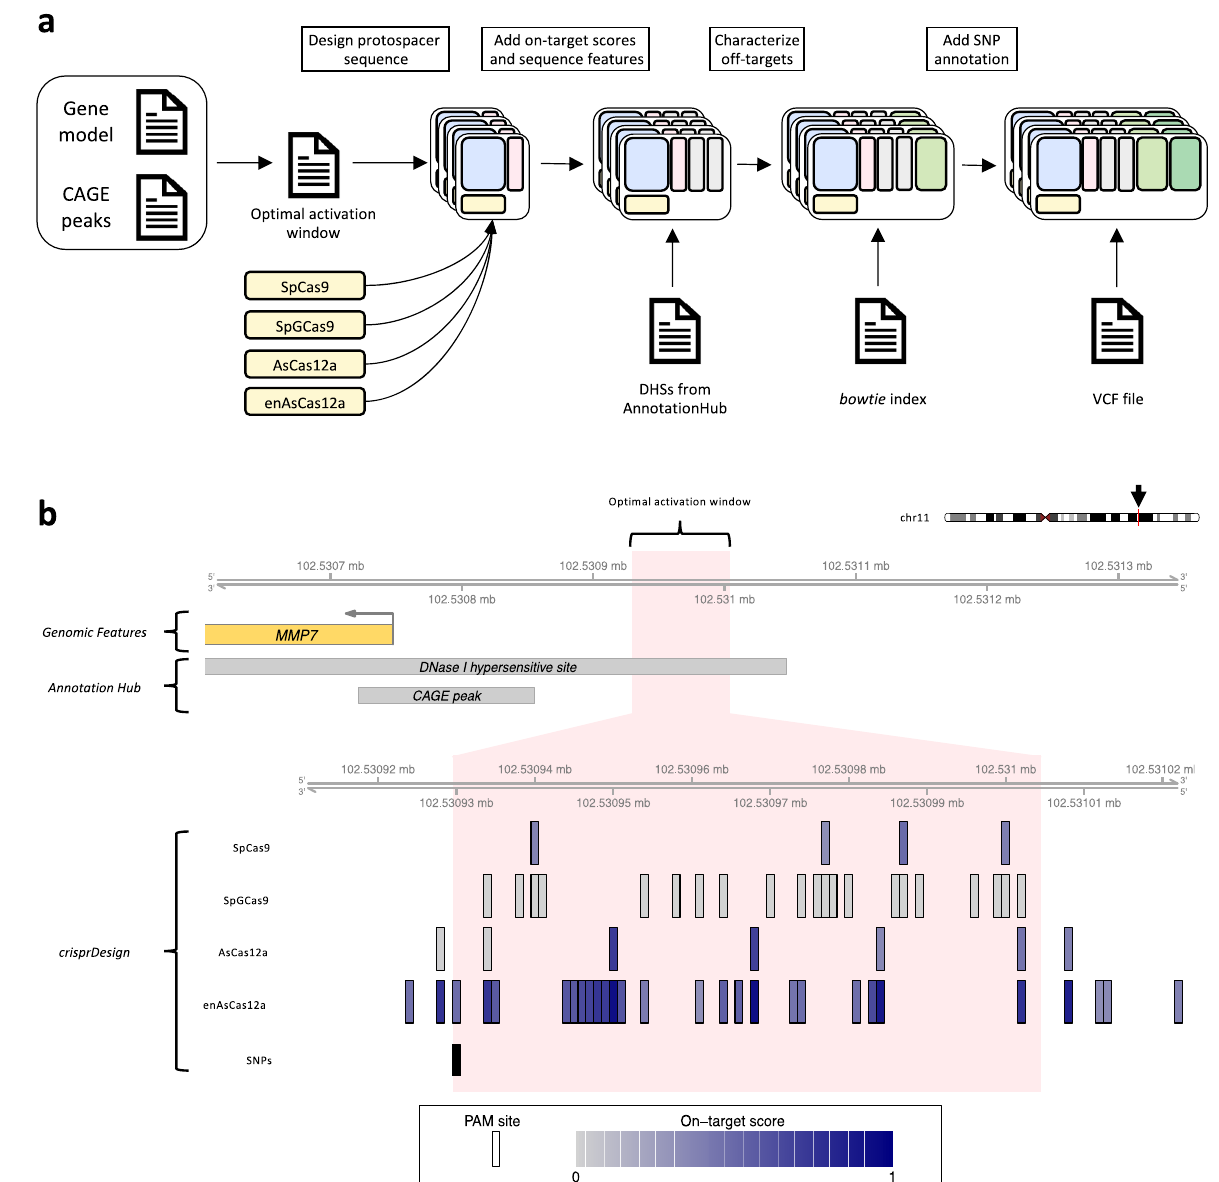
Fig. 6 | Design of CRISPRa gRNAs for human gene MMP7 for different CRISPR nucleases. a Schematic showing the steps involved in designing CRISPRa gRNAs targeting the promoterregion of MMP7 . Agene modeland alistof CAGEpeaksare used to de fi ne the optimal window for gene activation. A GuideSet is created separatelyforeachCRISPRnuclease.DNaseIhypersensitivesite(DHS)information is obtained from AnnotationHub and added to the gRNA annotation. b The top track shows the promoter region of human gene MMP7 on chromosome 11, including partof the 5 0 UTR of MMP7 (yellow).The DHSand CAGEpeakgrayboxes